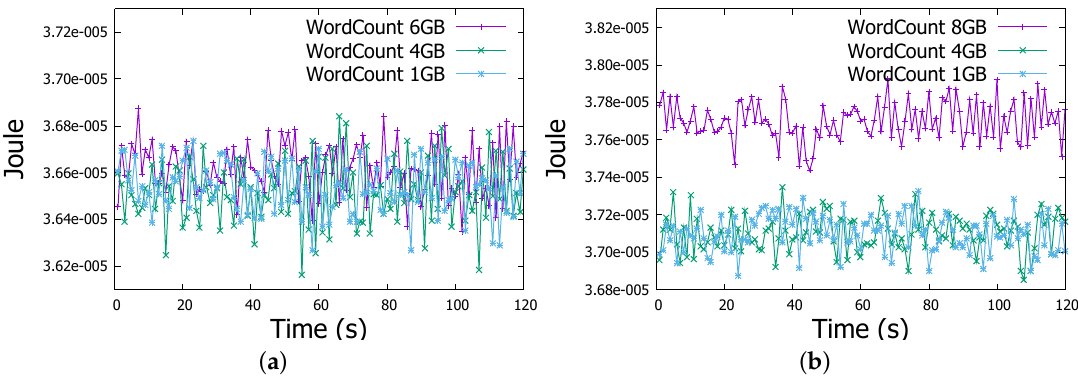
Figure 7. Energy measurement in a Raspberry Pi Worker node in WordCount job. ( a ) WordCount Job (1-4-6 GB files); ( b ) WordCount Job (1-4-8 GB files).